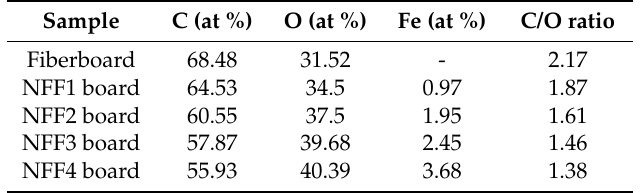
Figure 10. Magnetic hysteresis loops of binderless composite board with different mass fractions. The top left inset shows an enlarged view of the magnetic hysteresis loops. The bottom right inset shows the magnetic response under an external magnetic field. (A. pure fiberboard; B. NFF1 board; C. NFF2 board; D. NFF3 board; E. NFF4 board).